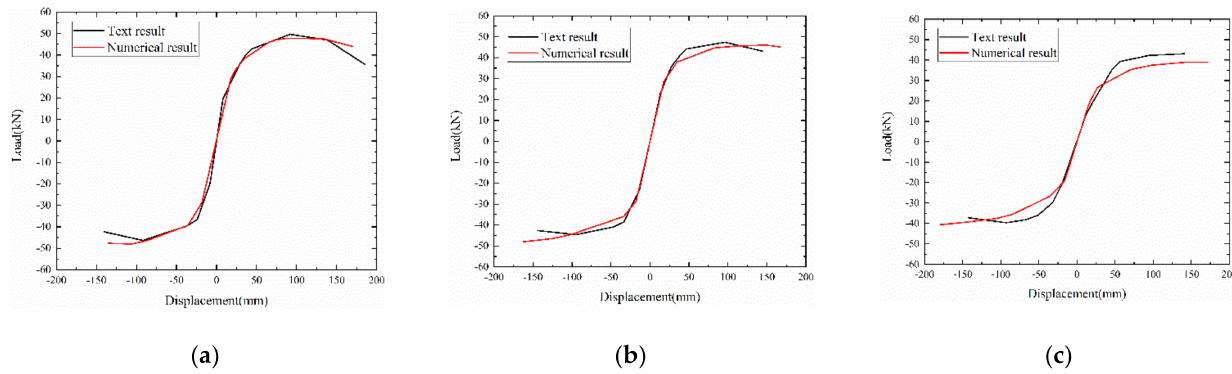
Figure 13. Comparison of skeleton curves, ( a ) Specimen D1, ( b ) Specimen C1, ( c ) Specimen